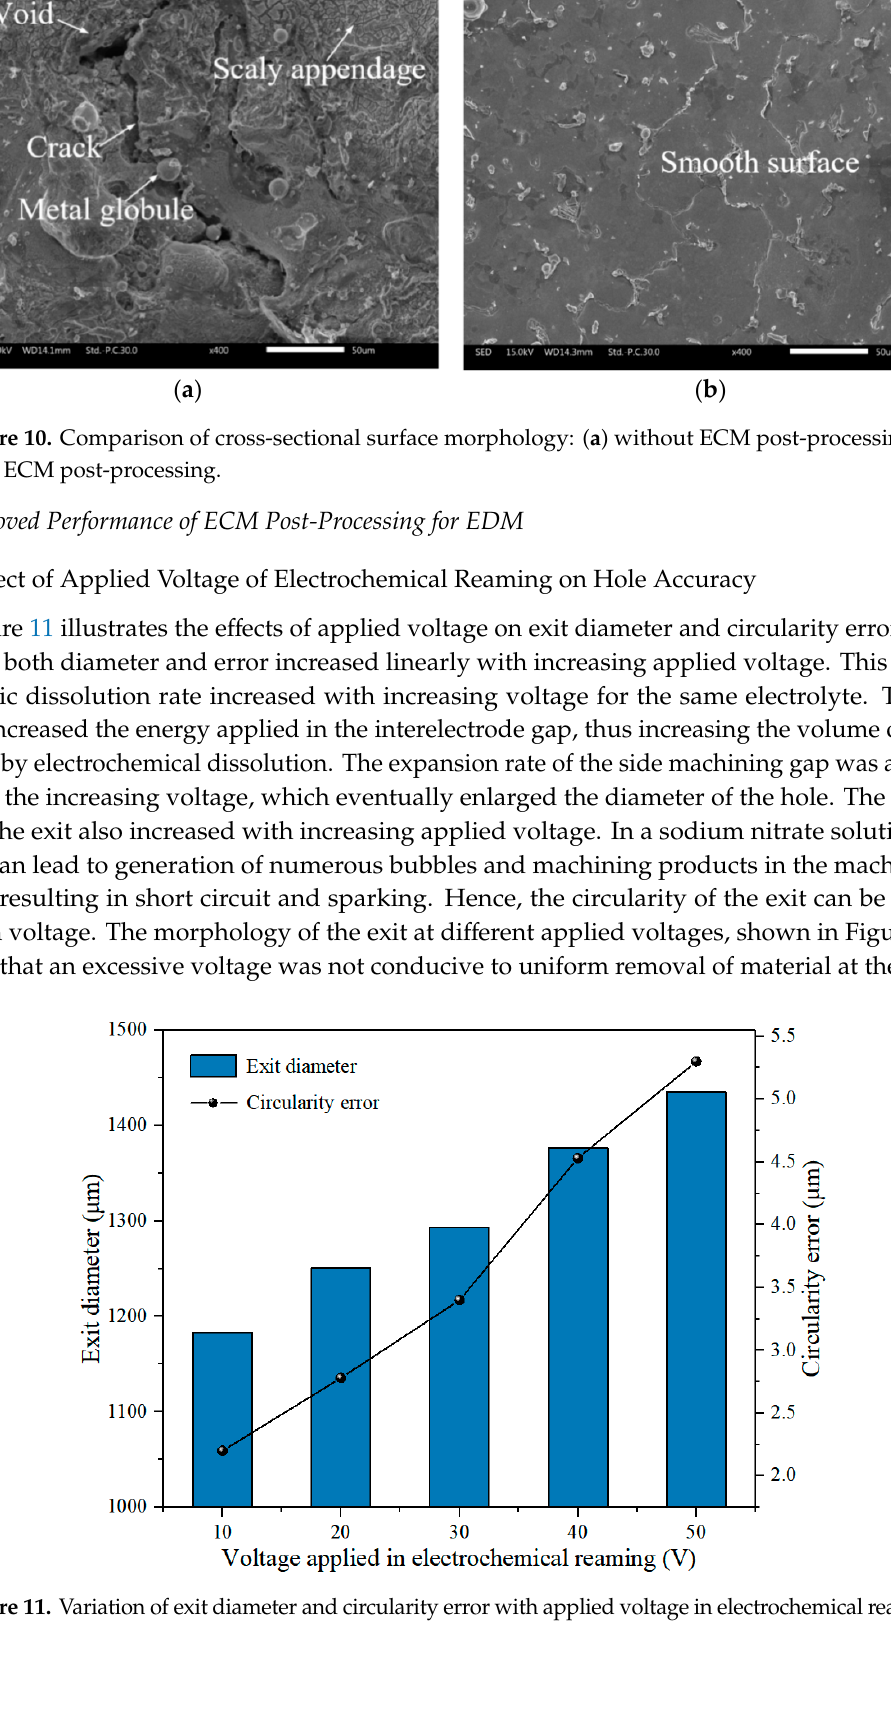
( e ) Figure 12. Morphology of the exit at different applied voltages in electrochemical reaming: ( a ) 10 V; ( b ) 20 V; ( c ) 30 V; ( d ) 40 V; ( e ) 50 V. The hole taper gradually decreased as the voltage increased from 10 V to 30 V, but once the voltage exceeded 30 V, the taper tended to increase, as shown in Figure 13. The variation of the taper in Figure 13 was consistent with the sections of the holes shown in Figure 14. This is because when the machining gap at the exit was smaller than that at the entrance, the difference of machining gap between entrance and exit led to a difference of electric field intensity. Thus, the electric field intensity at the exit was larger under the same voltage. The machining gap at the exit was smaller and the electric field intensity was larger; thus, electrochemical dissolution occurred at the exit prior to the entrance. Hence, the taper decreased as the voltage increased between 10 V and 30 V. However, an excessive voltage (30–50 V) caused a large number of bubbles and hydroxide electrolytes to be generated in the helical groove and the machining gap. The deteriorating flow field directly resulted in unstable machining and increased hole taper.